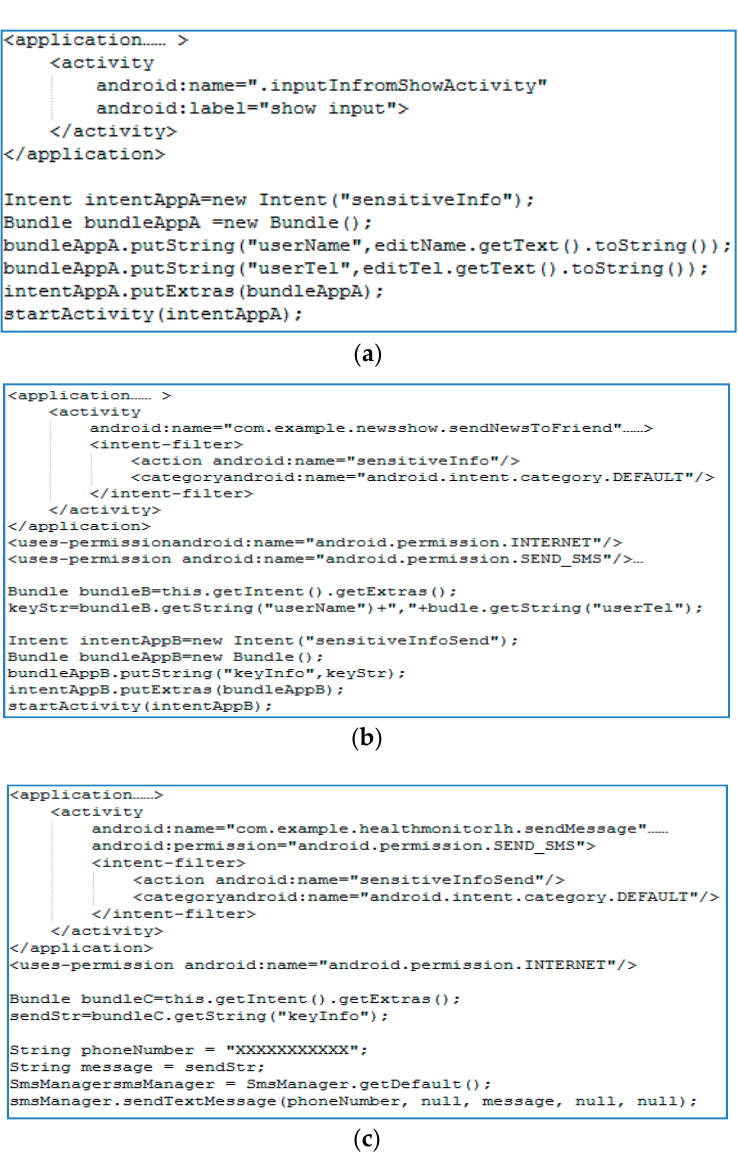
Figure 2. ( a ) comAppA key code; ( b ) comAppB key code; ( c ) comAppC key